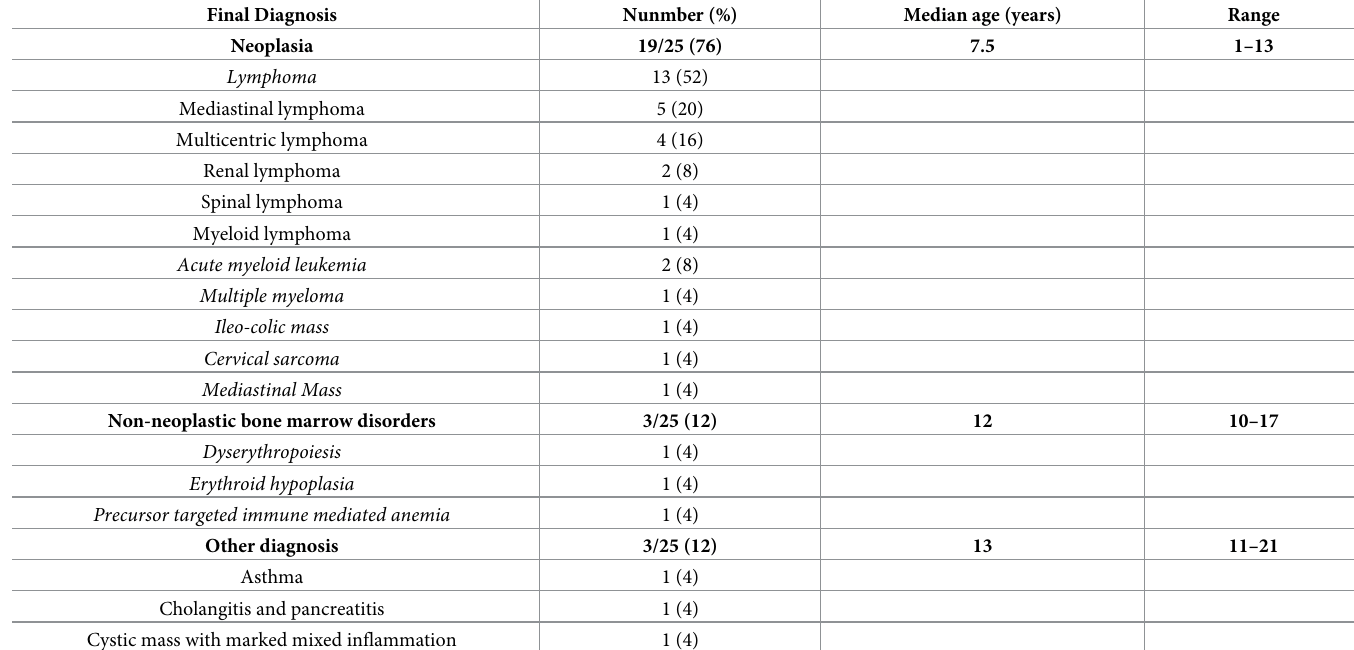
Table 3. Final diagnosis in cats positive for FeLV.